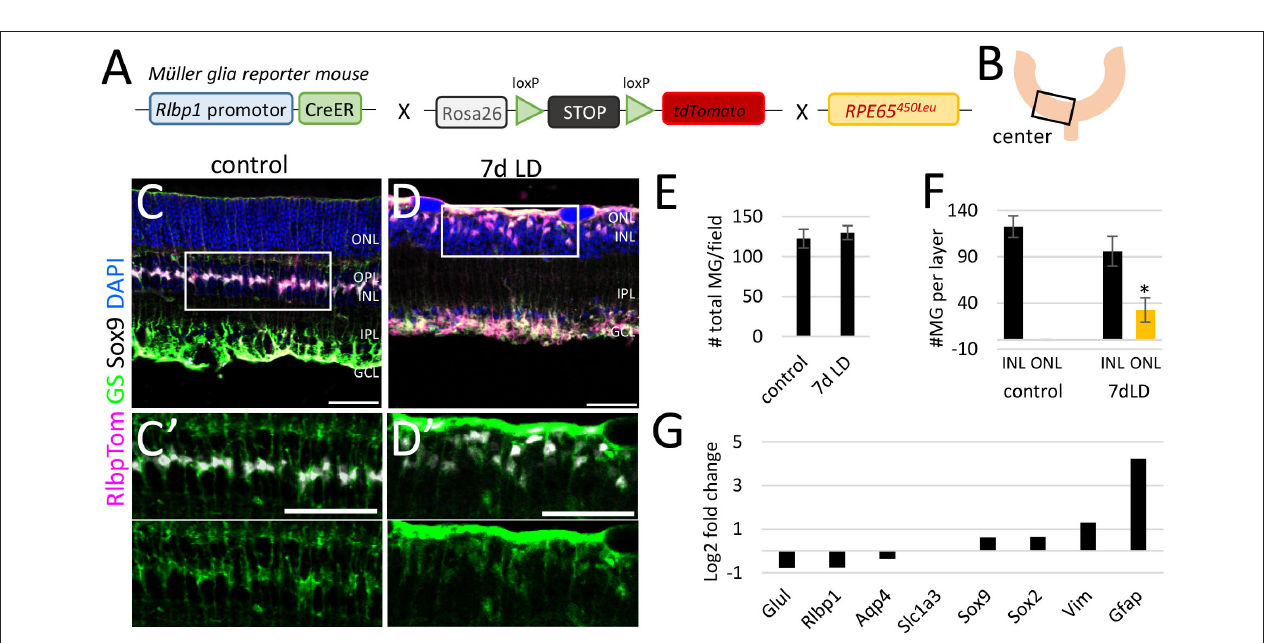
FIGURE 2 | Müller glia number and location in the central retina after light damage. (A) Schematic of the RlbpCreER: stop f / f -tdTomato: RPE65 450 Leu mouse. (B) Region of analysis. (C/C ′ ,D/D ′ ) Immunofluorescence labeling for tdTomato (MG), glutamine synthetase (GS), Sox9, and DAPI nuclear staining of retinal sections from undamaged controls and 7 days after light damage. (E) Number of MG per field in undamaged mice and 7 days after light damage (LD). (F) Number of MG in the INL and ONL in undamaged controls and 7 days after LD. (G) Expression levels (log 2 fold change light damage vs. control) of glial genes in undamaged (6 biological replicates, one technical replicate) and damaged retinas (five biological replicates, one technical replicate). Scale bars 50 µ m. Significant differences are indicated: * p < 0.05, Wilcoxon-test, n control = 5, n LD = 5. ONL: outer nuclear layer; OPL, outer plexiform layer; INL, inner nuclear layer; IPL, inner plexiform layer; GCL, ganglion cell layer; LD, light